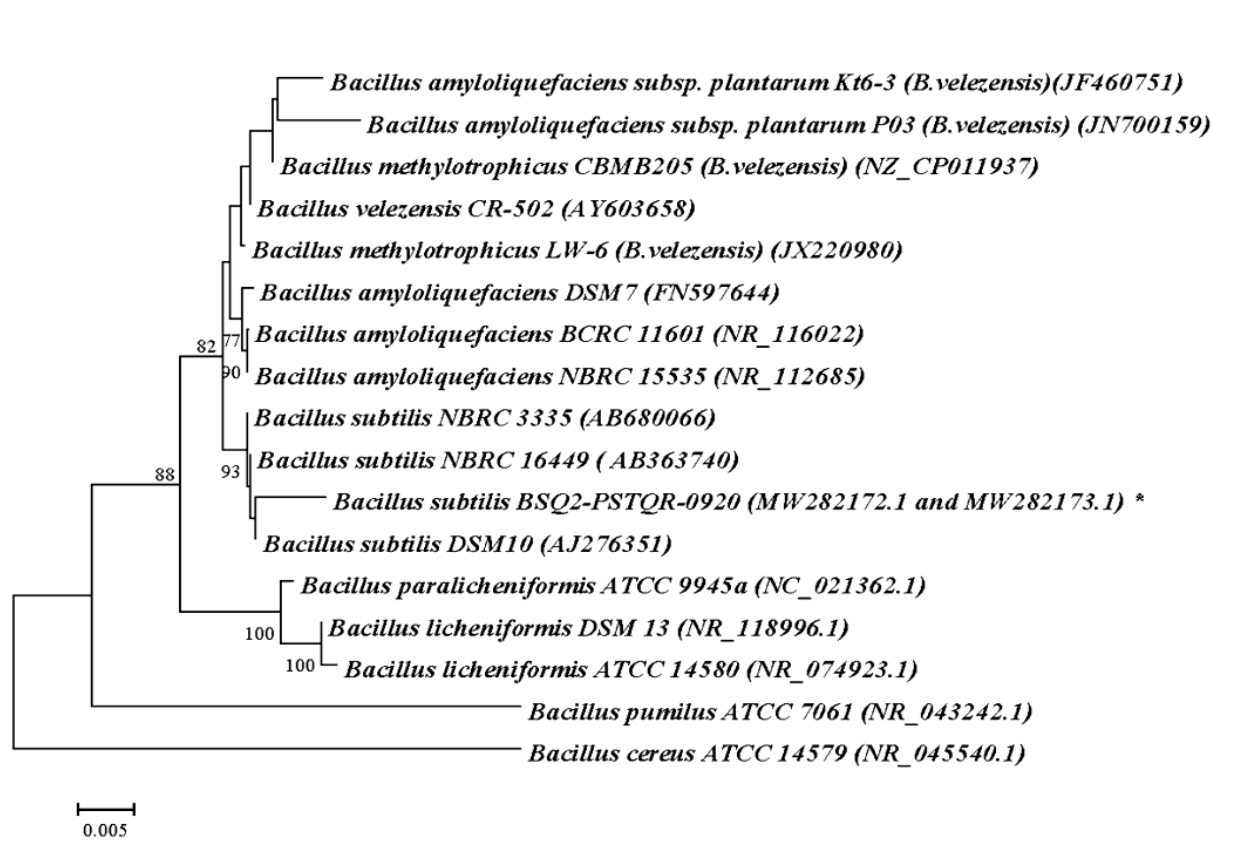
Figure 2. The phylogenetic relationships between different bacilli based on the 16S rDNA sequences. The dendrogram was built using the Neighbor-Joining method and Kimura’s 2-parameter model. The scale bar indicates 0.005 substitutions per nucleotide position. The analyzed strain is indicated by *.